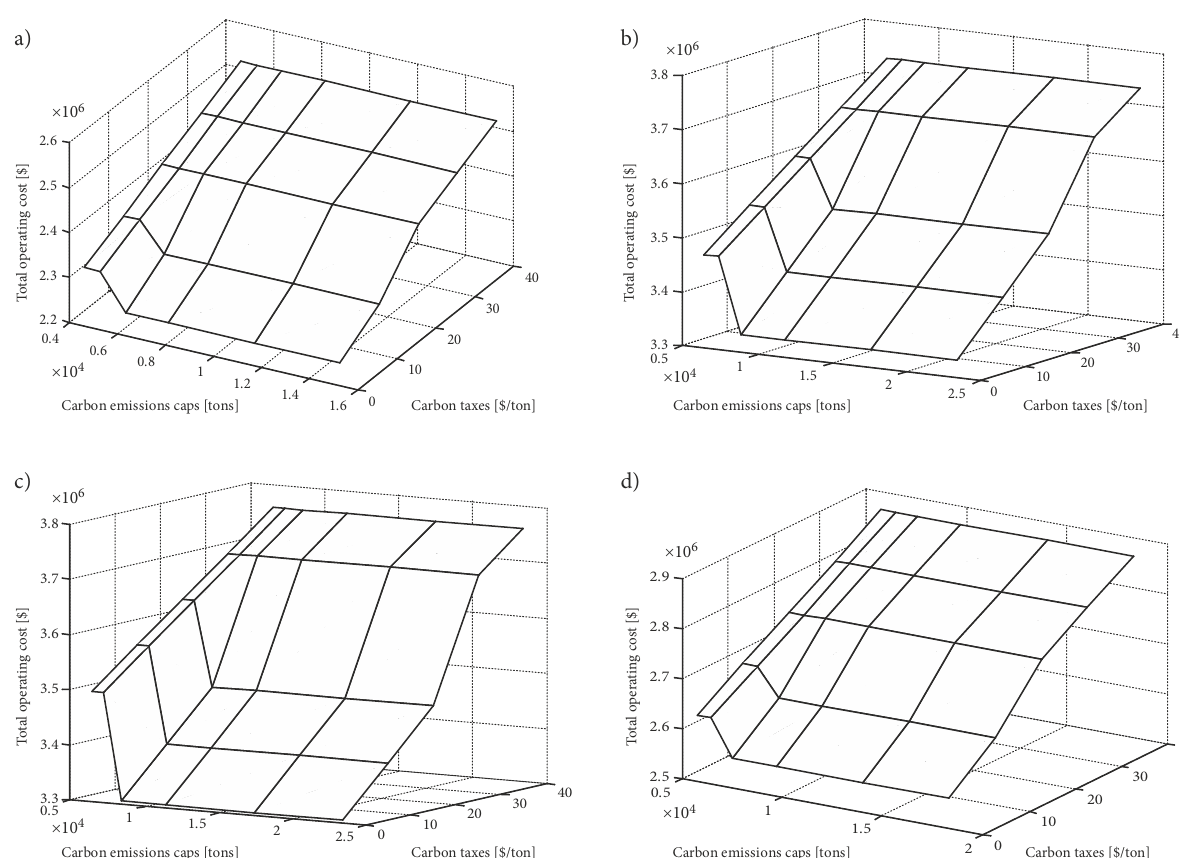
Figure 4. Changes in total weekly operating costs under different carbon emissions caps and different carbon